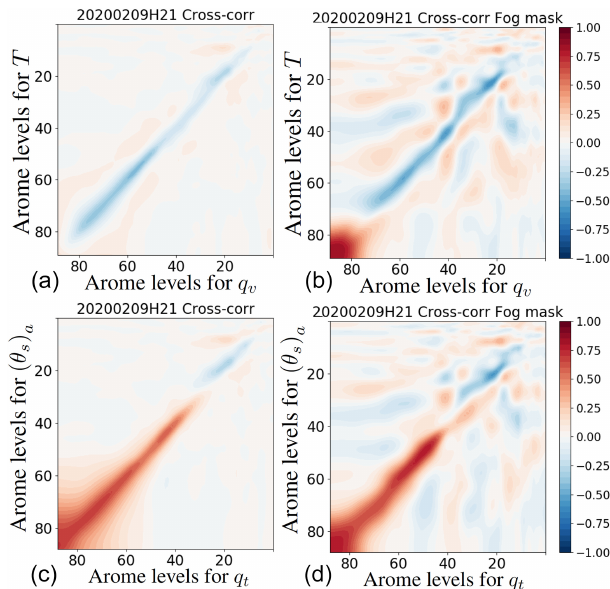
Figure 4. Same as Fig. 3, but at